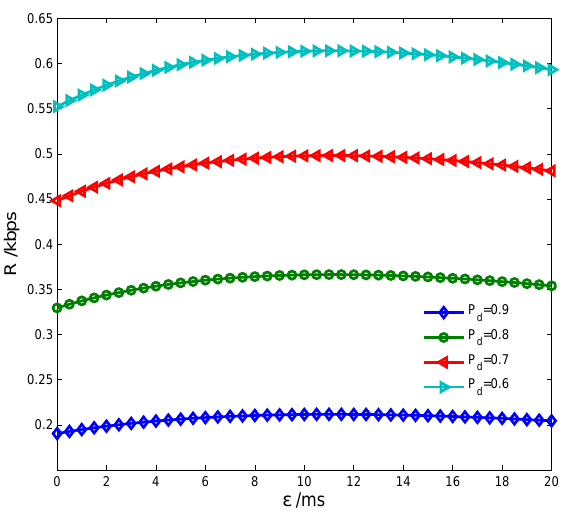
Figure 9. Transmission rate vs. detection probability with spectrum sensing time.